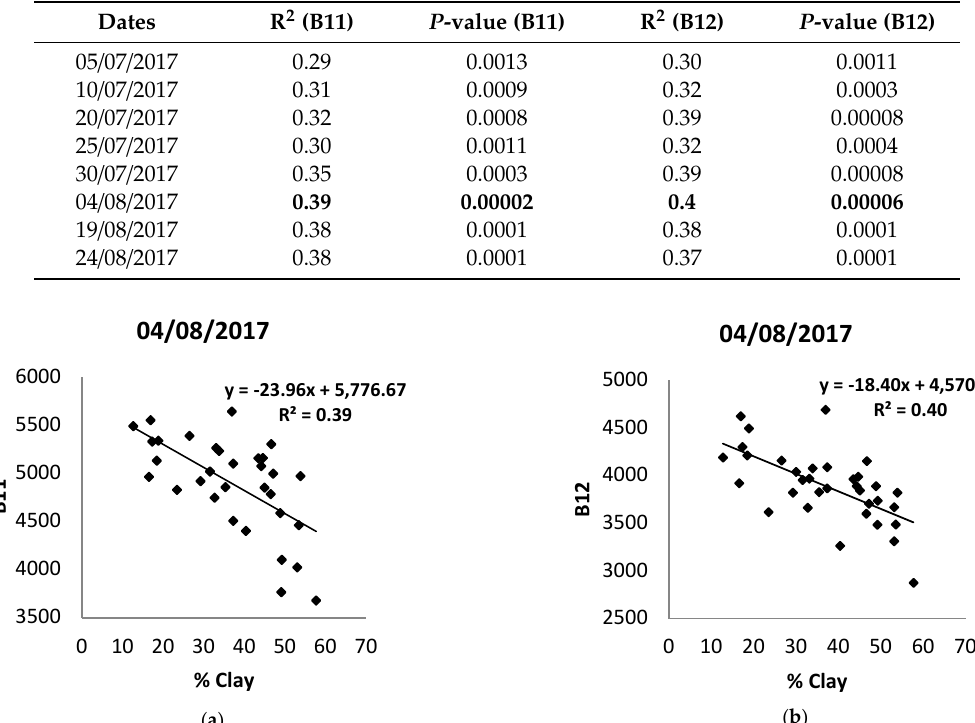
Figure 5. Soil clay content as a function of the SWIR bands of S-2, analyzed on August 4 th , 2017: ( a ) Band 11 (B11); ( b ) Band 12 (B12).